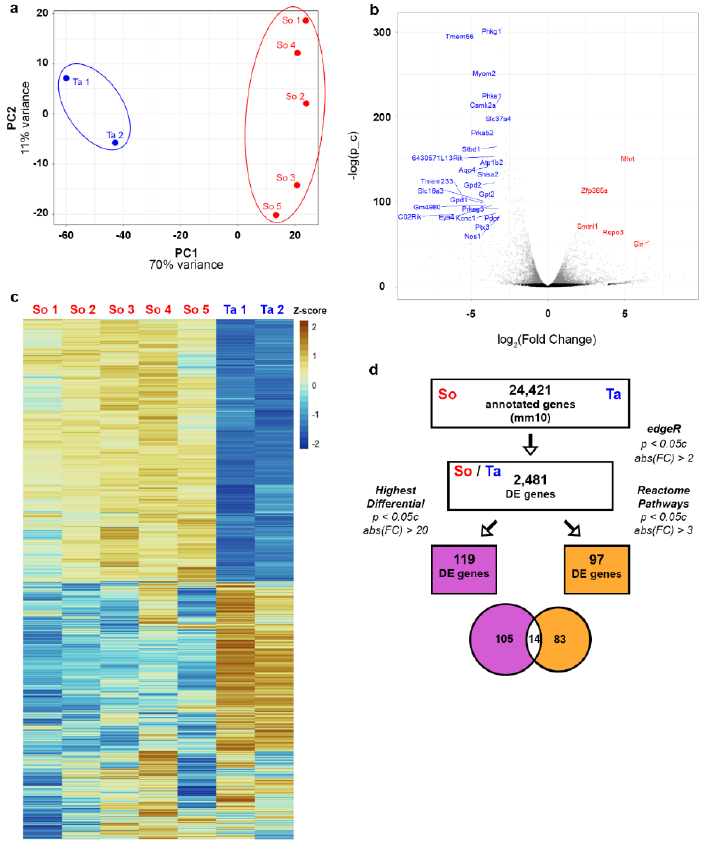
Figure 1. RNA-Seq workflow and data quality assessments. ( a ) Biplot of sample-standardized RNA counts (all genes) from the So (red) and Ta (blue) samples. Principal Component 1 (PC1) constitutes 70% of the variability among samples, and Principal Component 2 (PC2) constitutes 11% of the variability. ( b ) Volcano plot of all 24,421 annotated genes. Genes with an FDR-corrected p -value (p_c) less than 0.05 c are gray dots, and those with a p -value higher than 0.05 c are black. A select set of highly significant DE genes with large fold changes for So (log FC > 3, − log(p_c) > 50) are shown in red and for Ta (log FC < − 3, − log(p_c) > 75) in blue. ( c ) Heatmap of z-scored log-transformed read counts. Positive z-scores are in orange, and negative z-scores are in blue. Each sample is a column, and each row represents a statistically significant DE gene from the 2481 set. ( d ) Workflow used to reduce the number of genes for further analysis. A subset of the 2481 DE genes with extremely